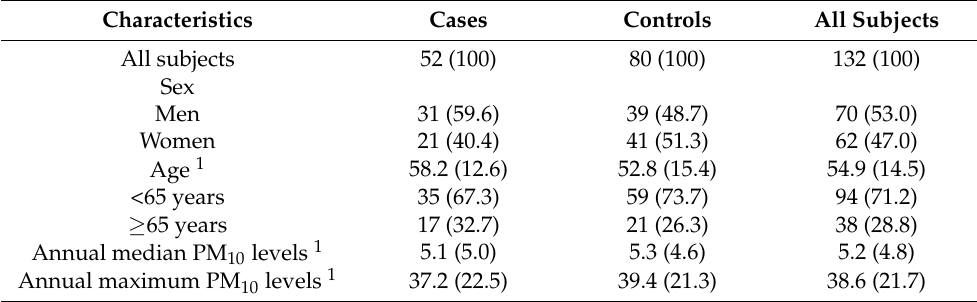
Table 1. Characteristics of the study population. Number (%) of subjects